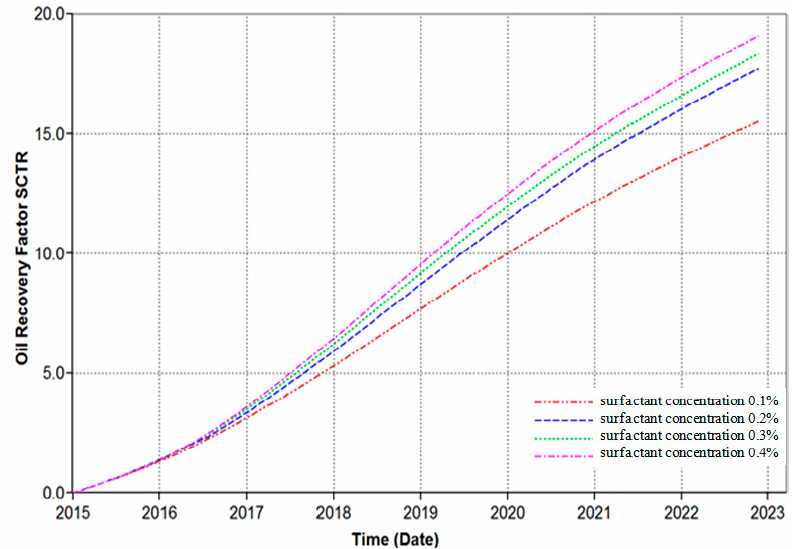
Figure 6. Recovery factor comparison of different experimental schemes.